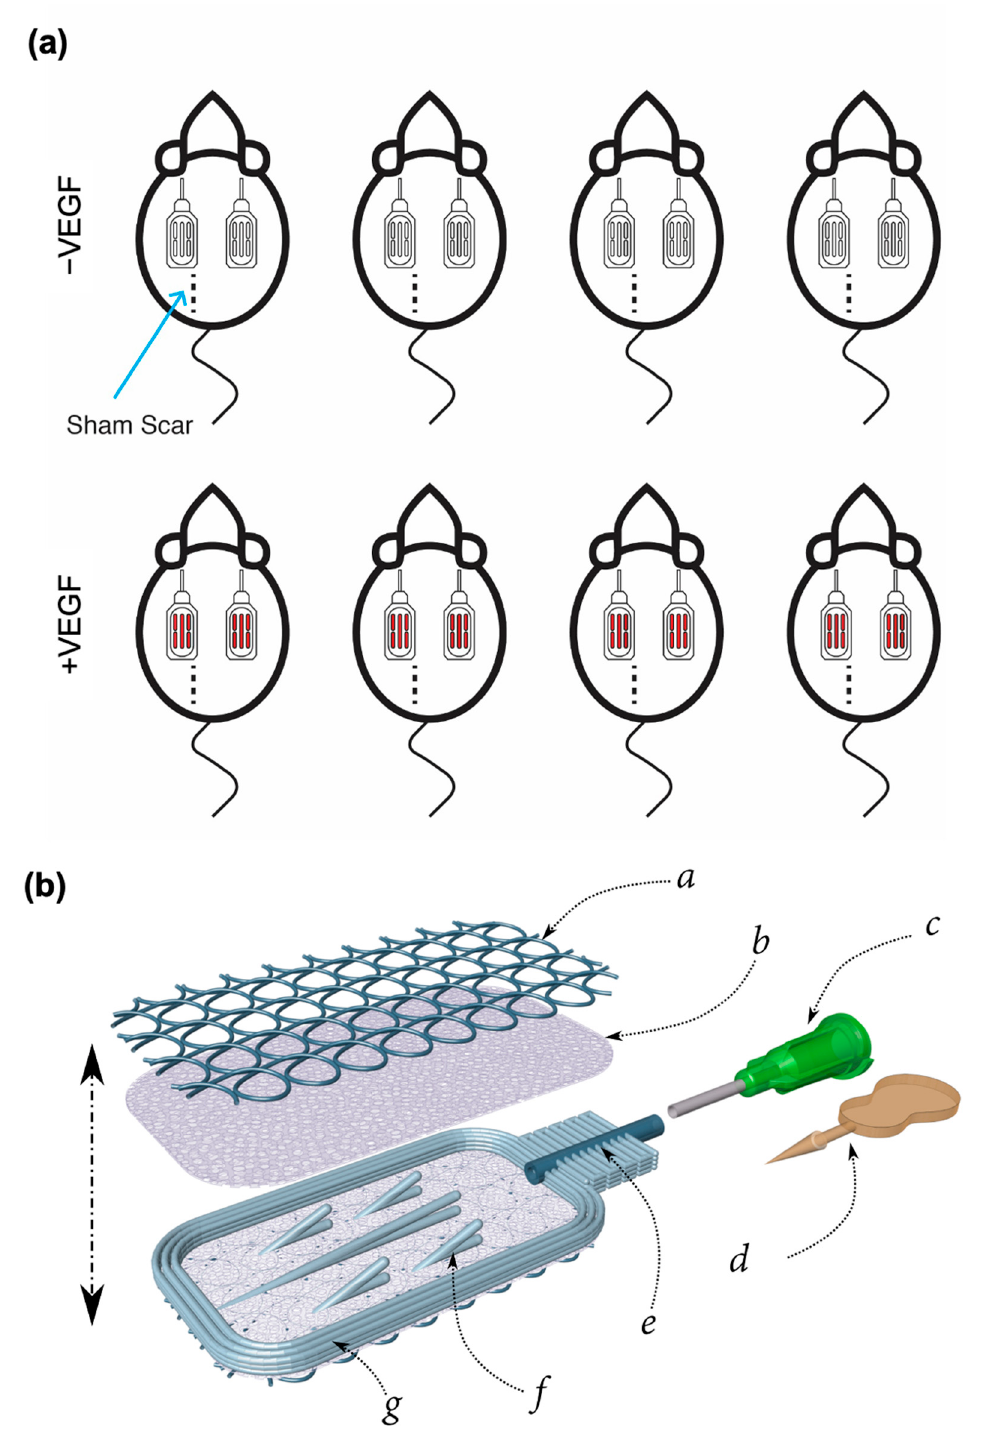
Figure 1. Study design and device overview ( a ) A total of 8 rats were each implanted with 2 textured silicone devices containing a standard HA gel − /+ VEGF microspheres, n = 4 per group. ( b ) Schematic of exploded rat-sized (10 × 20 × 1.2 mm) macroencapsulation device. a : Non-woven macro-porous pro-angiogenic coiling b : Microporous silicone blood barrier membrane c : Luer lock input nozzle d: Stopper (with break ‐ off tab) e: Input tube f: Pouch inner structure g: Pouch perime ‐ ter.